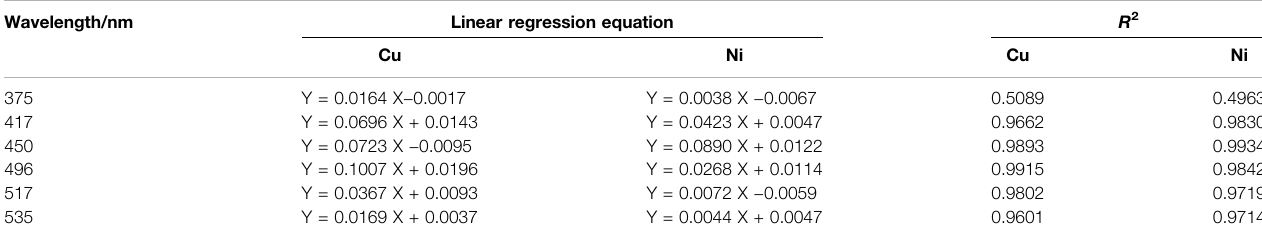
TABLE 1 | The linearity evaluation index of copper and nickel.